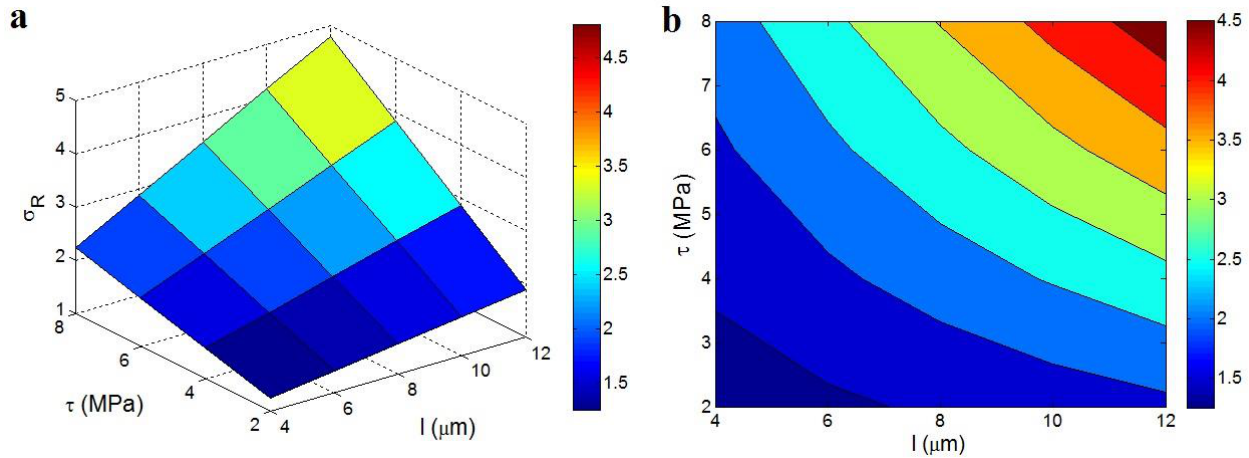
Figure 7. Influences of l and τ on the relative strength (Equation (17)) at σ m = 40 MPa, ϕ f = 0.02, R = 10 nm and t = 10 nm: ( a ) 3D and ( b ) contour plots.